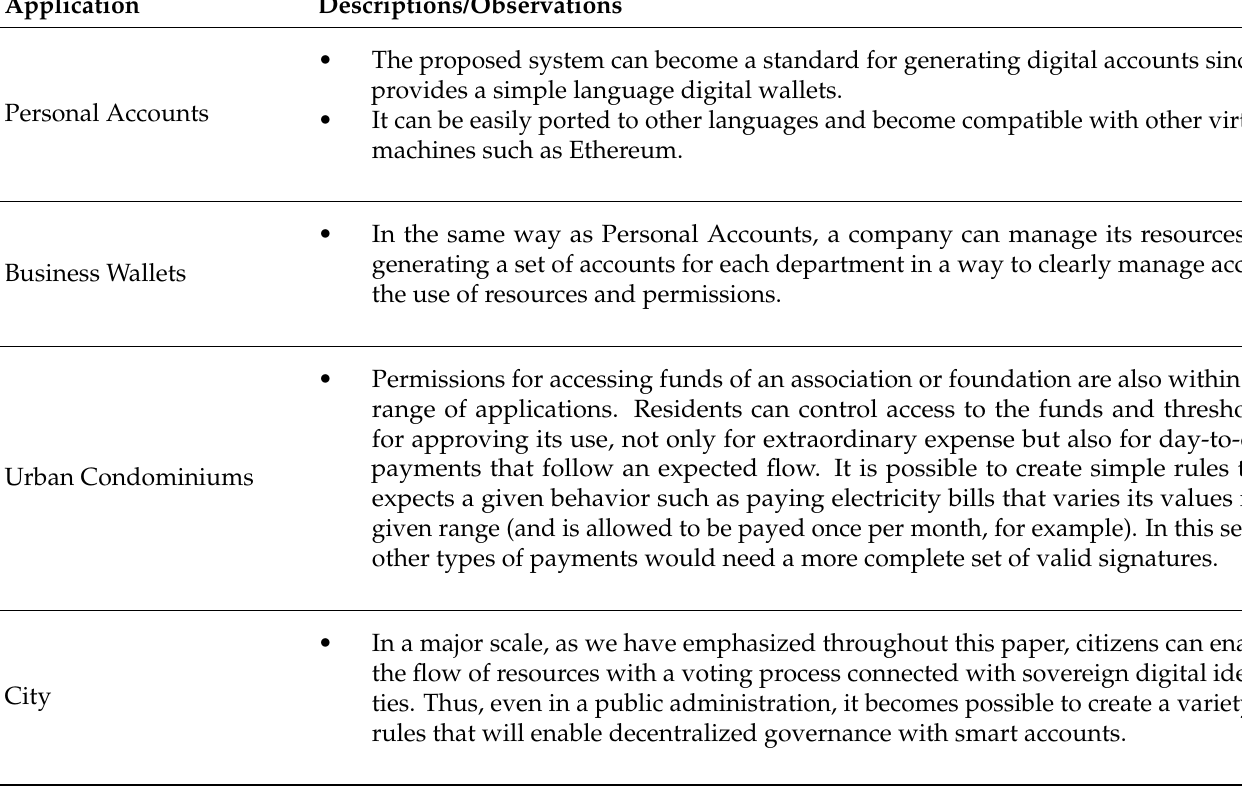
Table 2. List of possible applications of the proposed